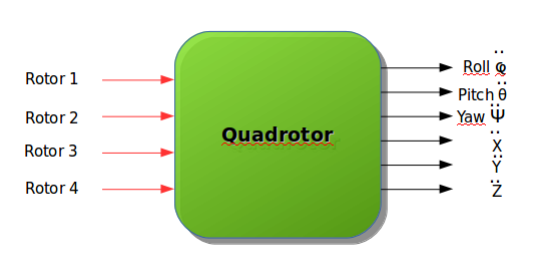
Figure 5. Dynamic Model of quadrotor with P p in Watt, Diam and P itch in inch, and N t in tr/mn . K is an adjustmen t par ameter , which depends on the propeller type, (APC: 1.11, Graupner: 1.18, Zing er: 1.31, Top flite 1.31,